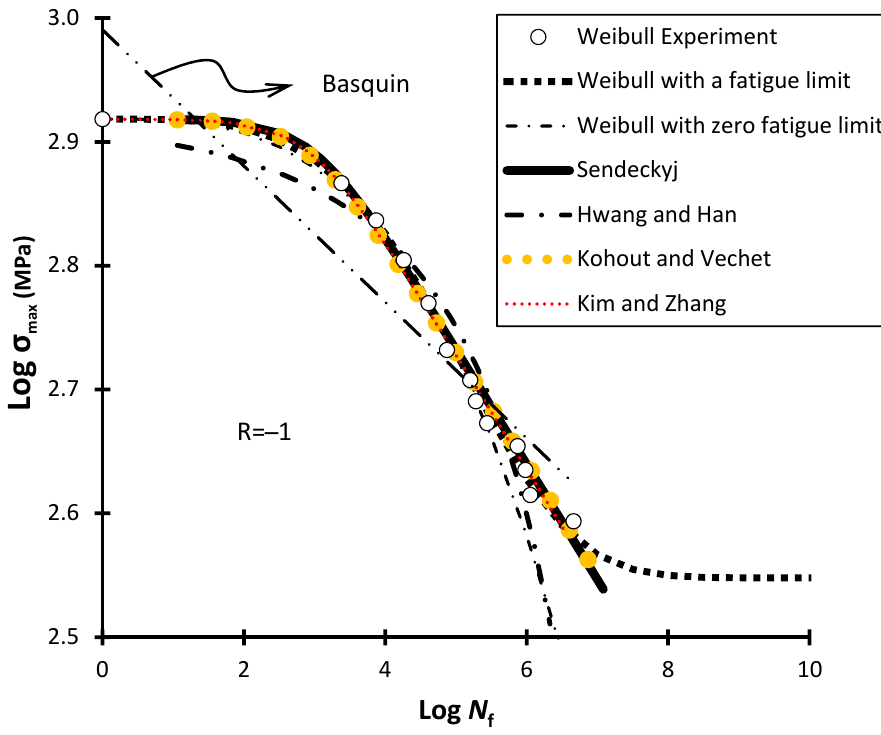
Figure 5. Weibull experimental data for R = − 1 plotted with data points having a probability of 50% failure for Bofors FR 76 Steel rotating beam test with σ uT = 829 MPa [18]. S-N curves were obtained from Weibull model with α = 21 × 10 − 4 and β = 3.8 for an assumed σ ∞ = 353 MPa; Weibull model with α = 0.003 and β = 3.1 for an assumed σ ∞ =0; Sendeckyj model with α = 0.001 and β = 0.093; Hwang and Han model with α = 35 and β = 0.21; Kohout and Vechet model with α = 776.25 and β = − 0.0895; and Kim and Zhang model with α = 10 − 38.44 , β = 11.809 and N 0 = 0.5.